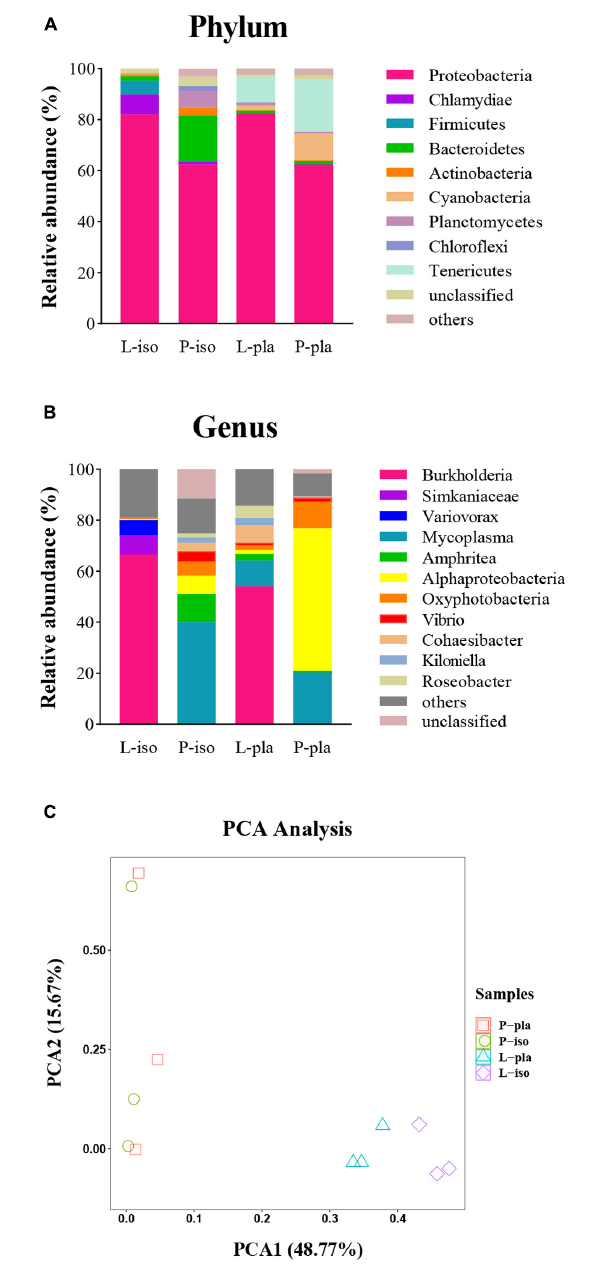
FIGURE 3 | Composition of intestinal microflora of P. maxima fed with different diets. (A) Microbiota composition at the phylum level with relative abundance. (B) Microbiota composition at the genus level with relative abundance. “Others” meant the means of the sum of phylum or genus with relative abundance < 2% in L-iso, P-iso, L-pla, P-pla groups, respectively. (C) PCA analisys of bacteria community in different diet groups. The colored plot represents the bacteria from L-iso, P-iso, L-pla, and P-pla groups.